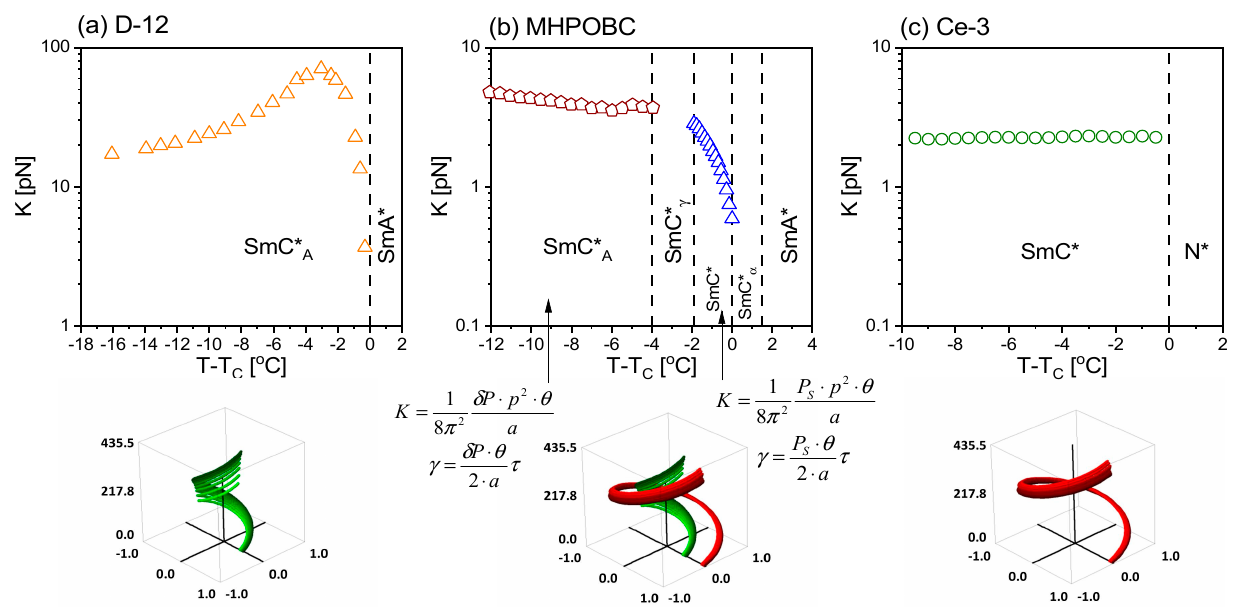
Figure 2. The elastic constant K versus temperature for three different materials in the low electric field range: ( a ) D-12, ( b ) MHPOBC and ( c ) Ce-3 showing different dependencies of the elastic constant depending on the type of adjacent phases. To illustrate the difference of the pitch behavior, schematic cartoons for one period of pitch for compounds are shown.